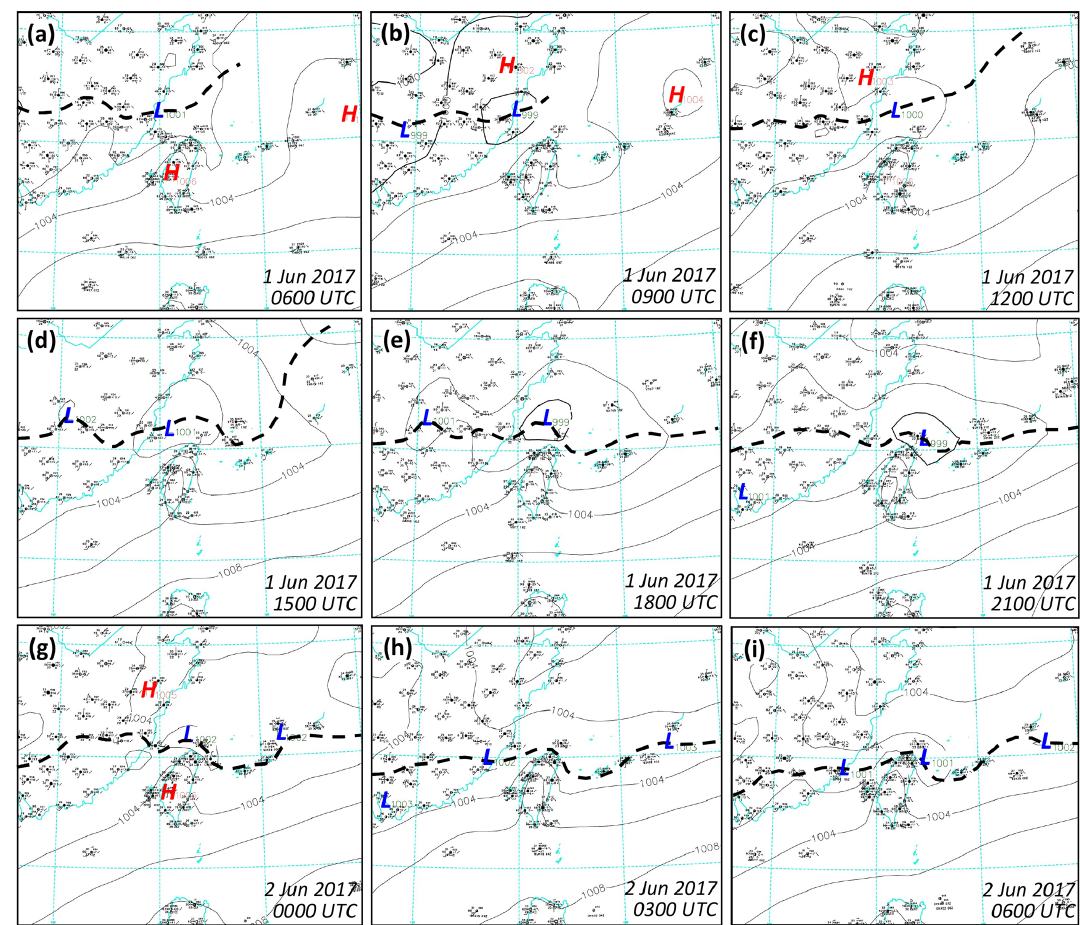
Figure 16. The CWB surface regional weather charts near Taiwan every 3h from (a) 06:00UTC on 1 June to (i) 06:00UTC on 2 June 2017. In the panels, the mean sea-level pressure (MSLP,hPa) is analyzed with isobars every 2hPa with closed high/low centers labeled (source: CWB), and the surface frontal position is also marked (thick dashed